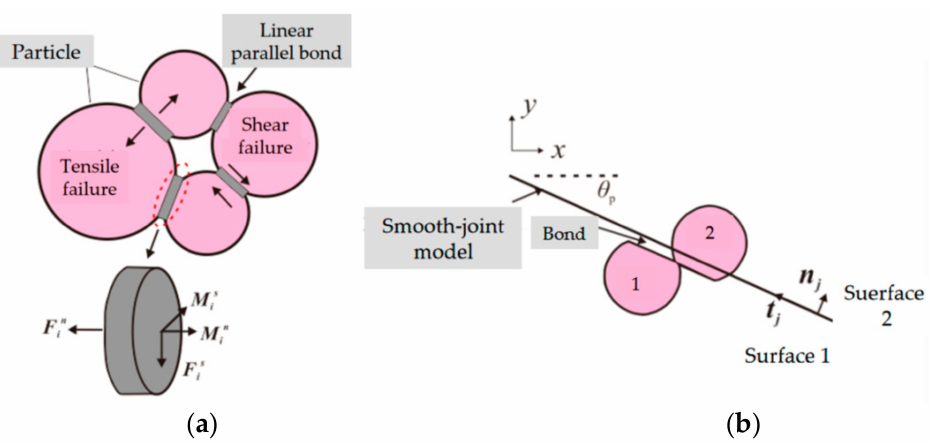
Figure 6. Linear parallel bond model and smooth-joint model between particles: ( a ) Linear parallel bond model; ( b ) Smooth-joint